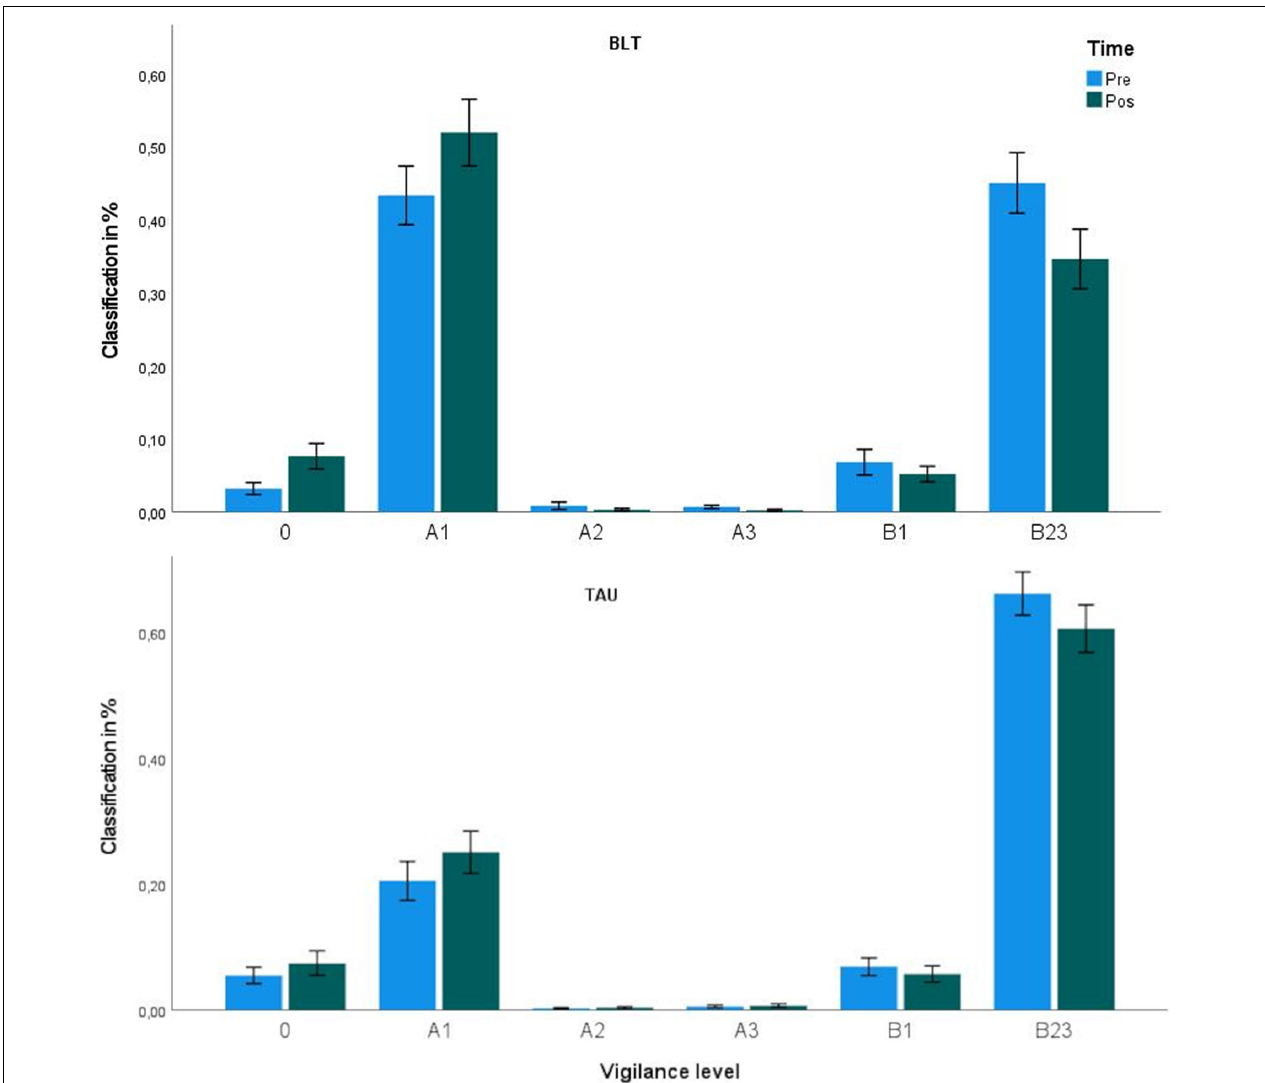
FIGURE 1 | Vigilance classification distribution. BLT, Bright Light Therapy; shown are the mean percentage of vigilance level classifications. The 20 min resting-state EEG was second-wise classified by the VIGALL